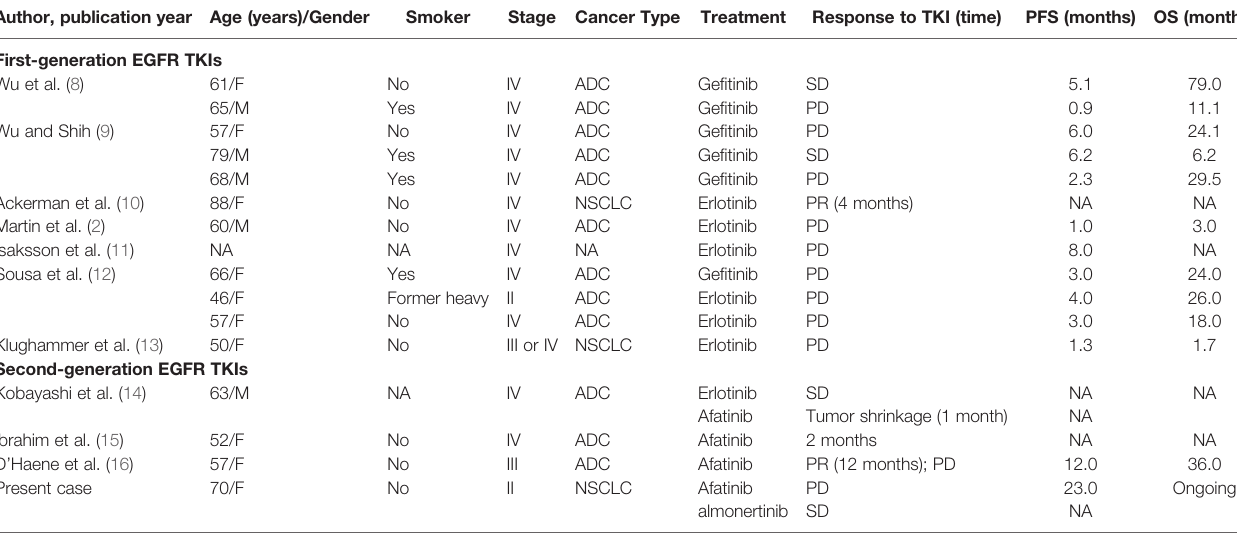
TABLE 2 | All reported cases of the EGFR E709_T710delinsD mutation in lung adenocarcinoma patients treated with EGFR